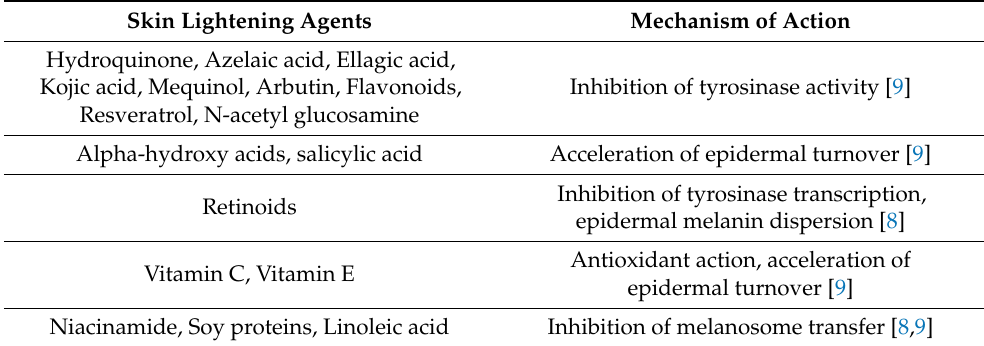
Table 1. Mechanisms of action of legally authorised skin-lightening